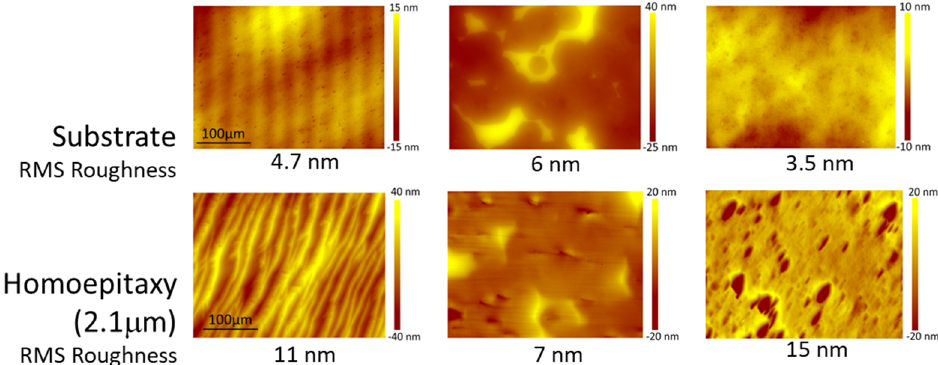
Figure 5. Optical profilometry images of the surface of 3 substrates before (top row) and after (bottom row) 2.1 µm of homoepitaxial GaN grown by MOCVD. Reprinted from [20] with permission from Elsevier.